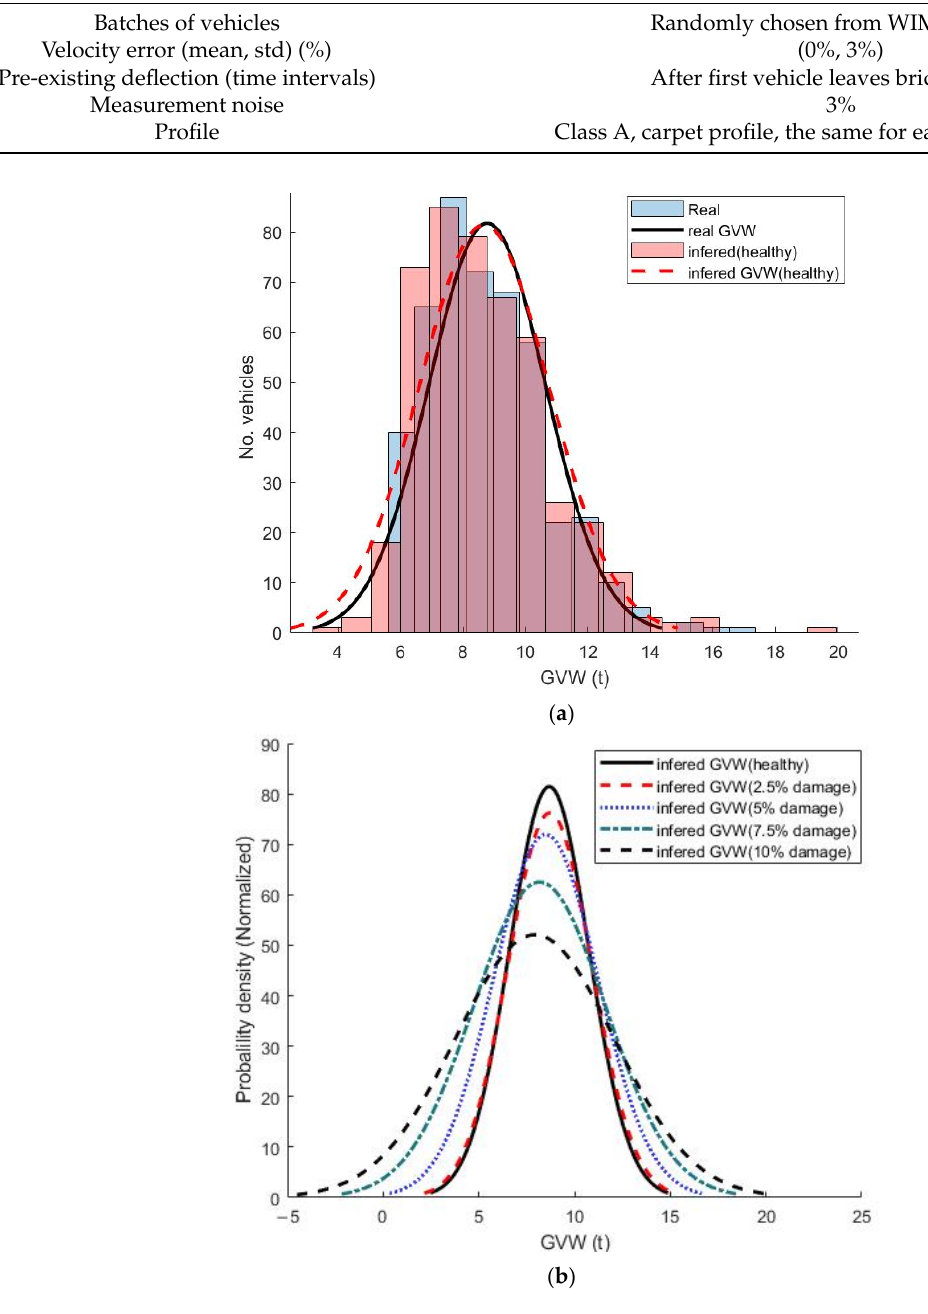
Figure 8. Inferred GVWs for 500 vehicles: ( a ) Histogram for healthy and fitted Gaussian distributions of inferred and true vehicle weights; ( b ) fitted Gaussian distributions for healthy and damaged bridges.